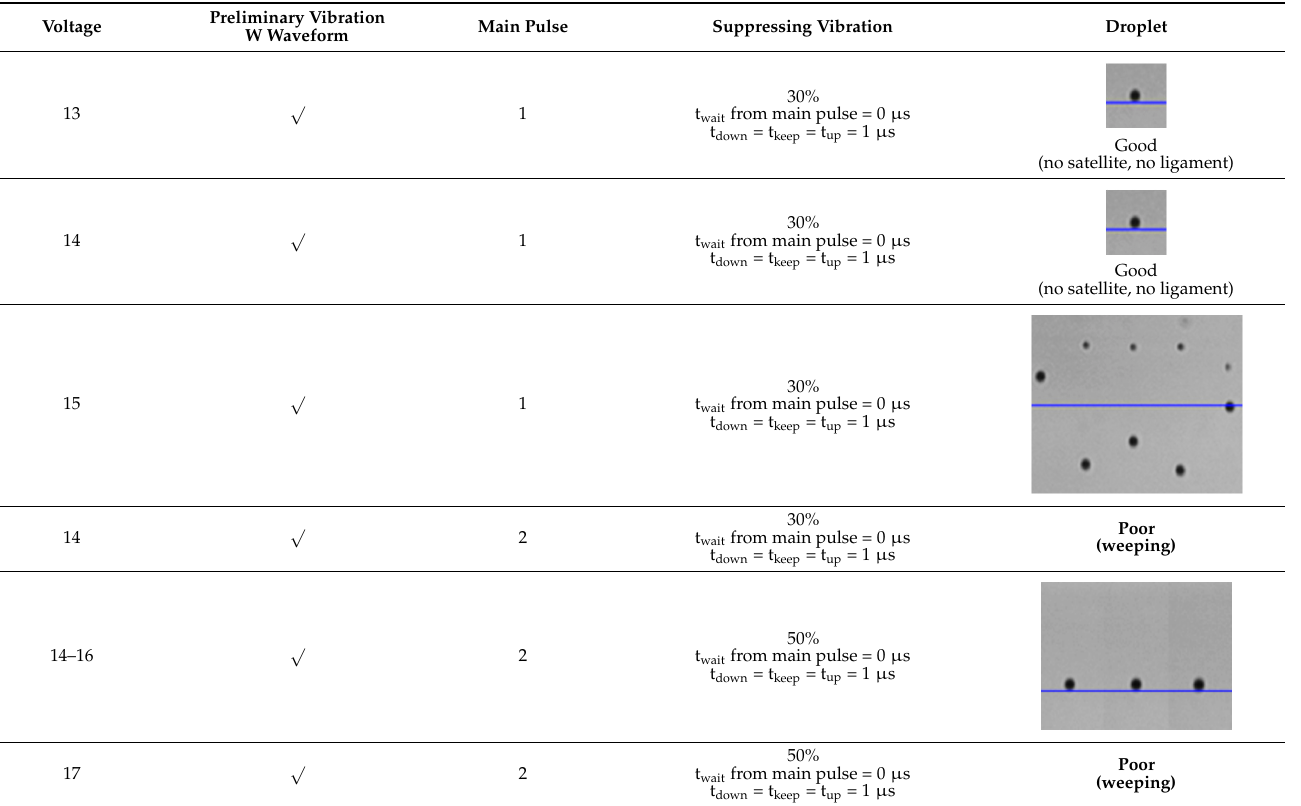
Table 1. Examination results of unmodified W waveform on edible ink.